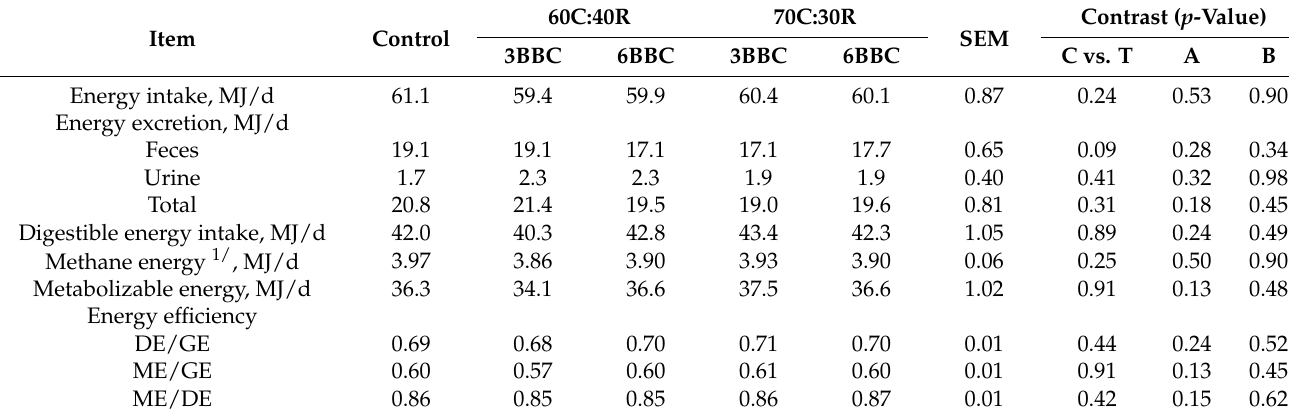
Control = 70C:30R ratio without BBC supplementation, C vs. T = comparing the control treatment to other treatments, A = the effect of concentrate-to-roughage ratios, B = the effect of BBC supplementation, GE = gross energy, DE = digestible energy, ME = metabolizable energy, CP = crude protein, SEM = standard error of the mean. 1/ Methane energy (MJ/d) = 0.065 × GEI (IPCC,